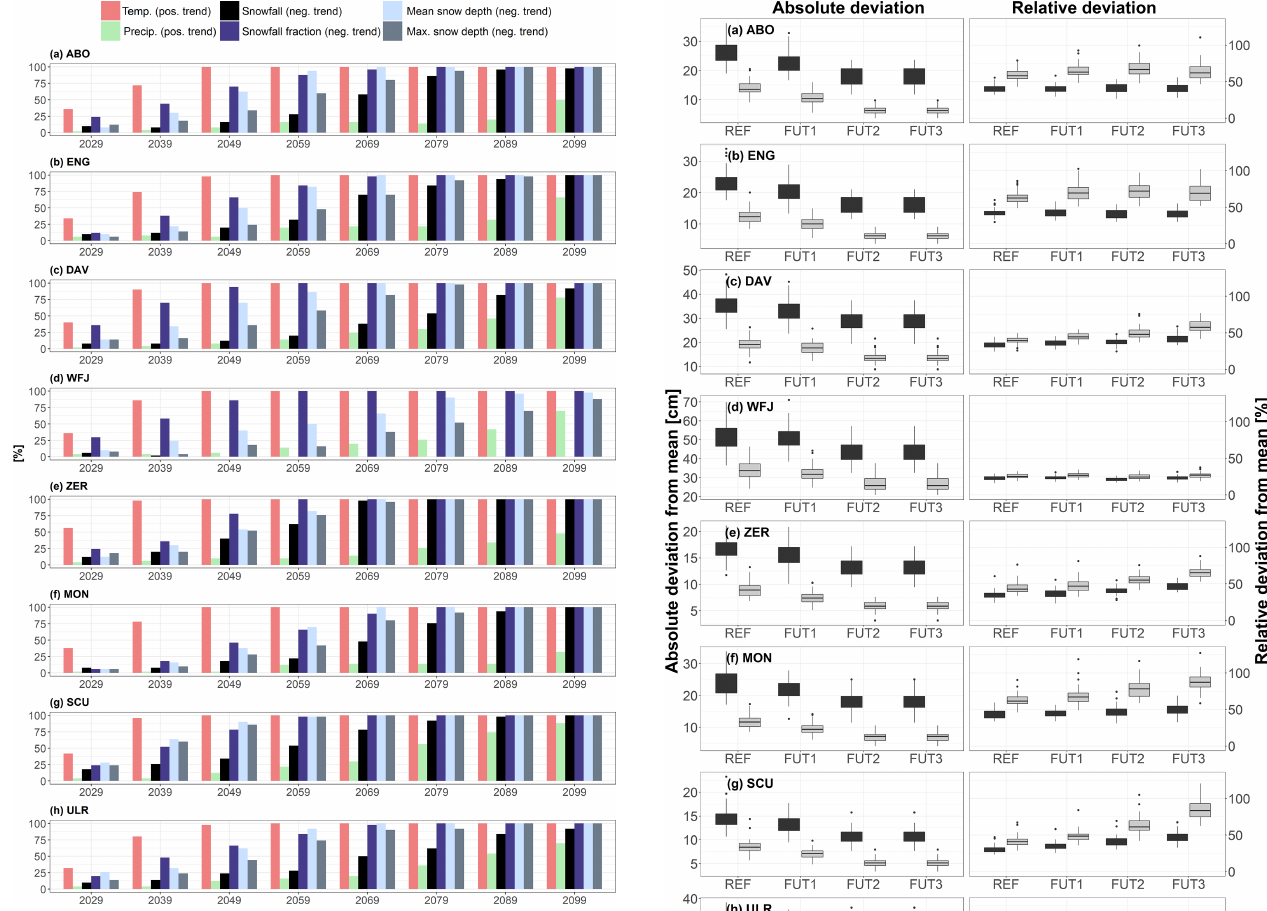
Figure 8. Percentage of significant trends ( p value of 5%) for time series of temperature, winter precipitation sums, snowfall fraction, snowfall sums, and mean and maximum snow depth starting in 2000 and ending between 2029 and 2099 for all case studies. See Table 1 for the abbreviations of case studies.